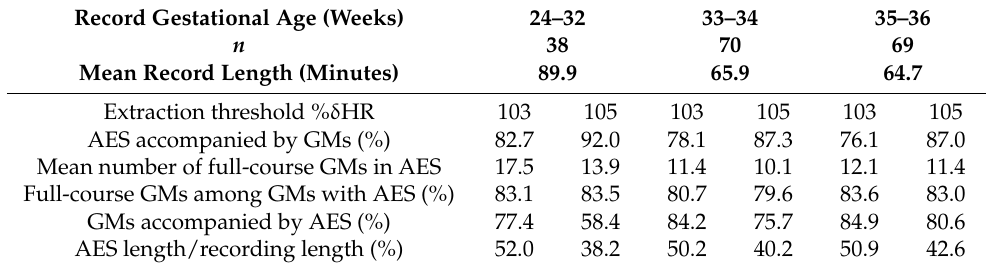
Table 1. Automatic extraction of GMs using heart rate in the supine position.